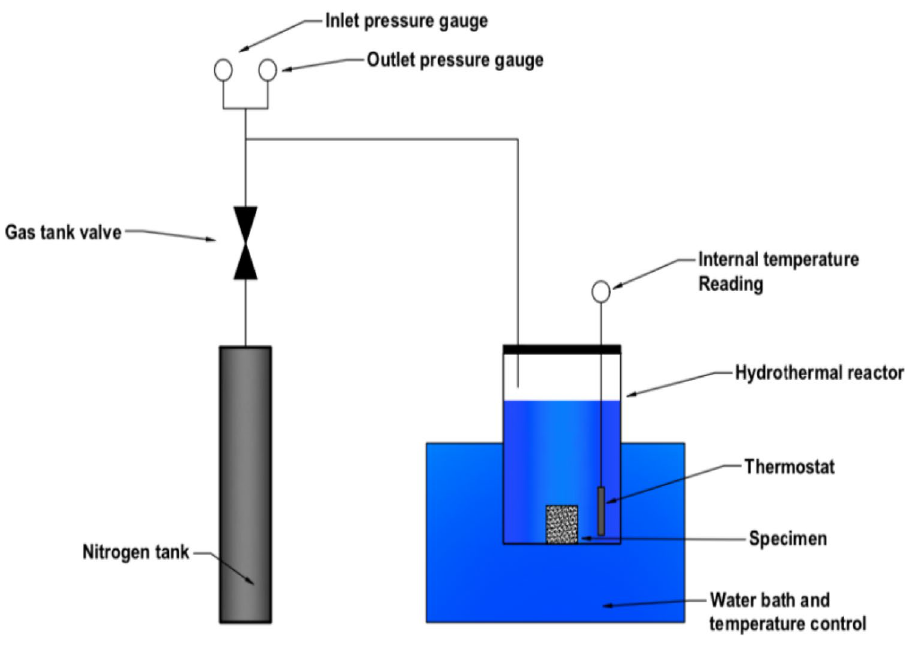
Figure 1. Shale treatment